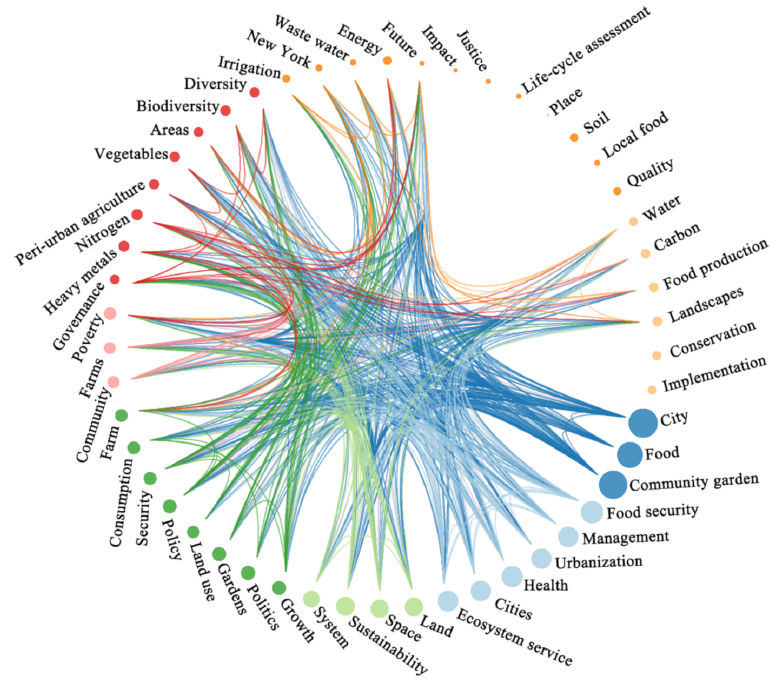
Figure 6. Co-occurrence analysis of keywords in the literature on urban agriculture from 2001 to